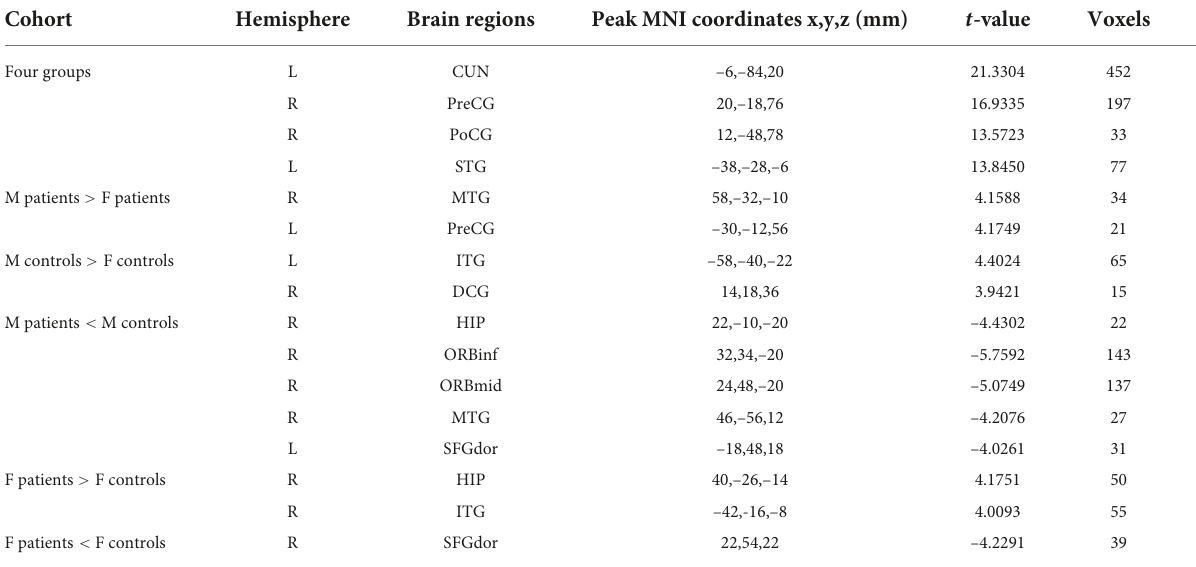
TABLE 4 Significant brain regions identified for ASL analyses of CBF.